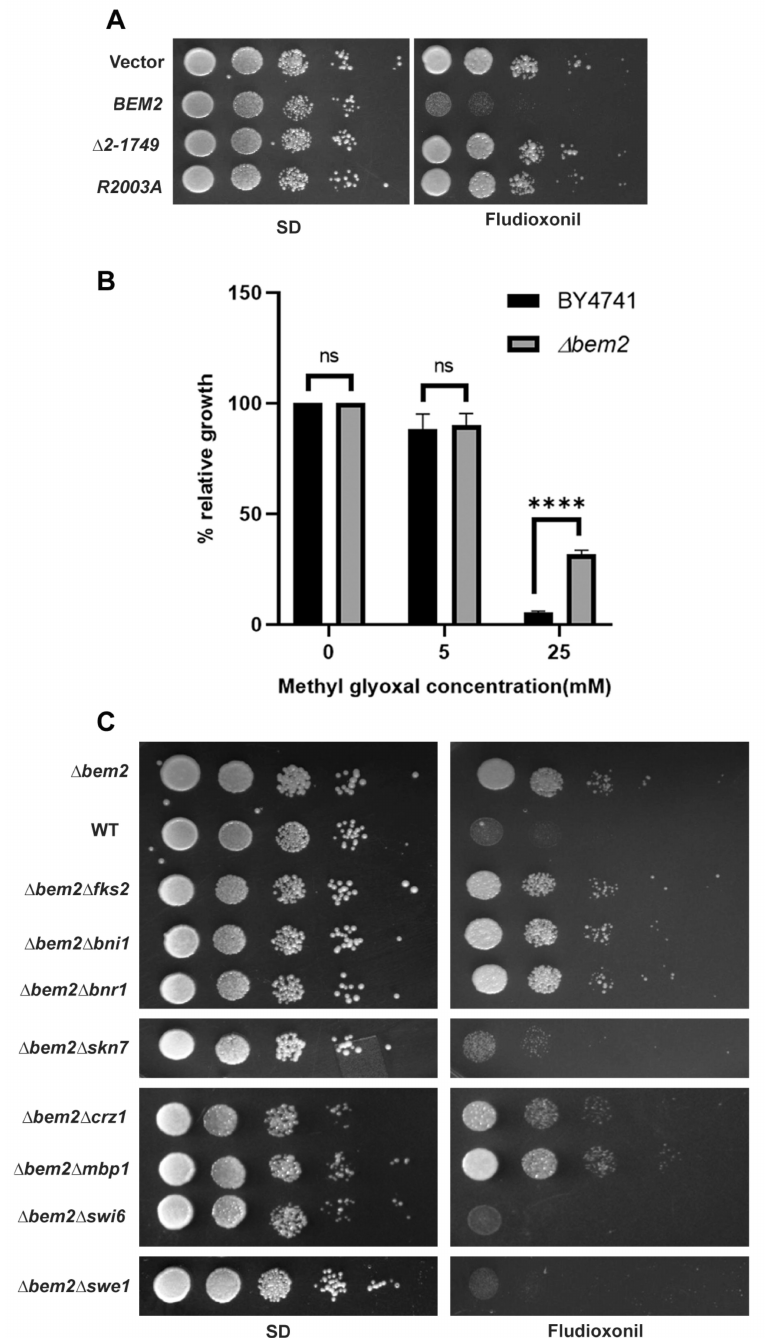
Figure 3. Functional analysis of fludioxonil resistance phenotype of ∆ bem2 mutant.( A ) Fludioxonil sensitivity of different bem2 mutants by dilution spotting. Spot assays of S. cerevisiae strain ∆ bem2 harboring plasmid pRS313 (vector), pBEM2-313 ( BEM2 ), pBEM2-1749 ( ∆ 2-1749), and